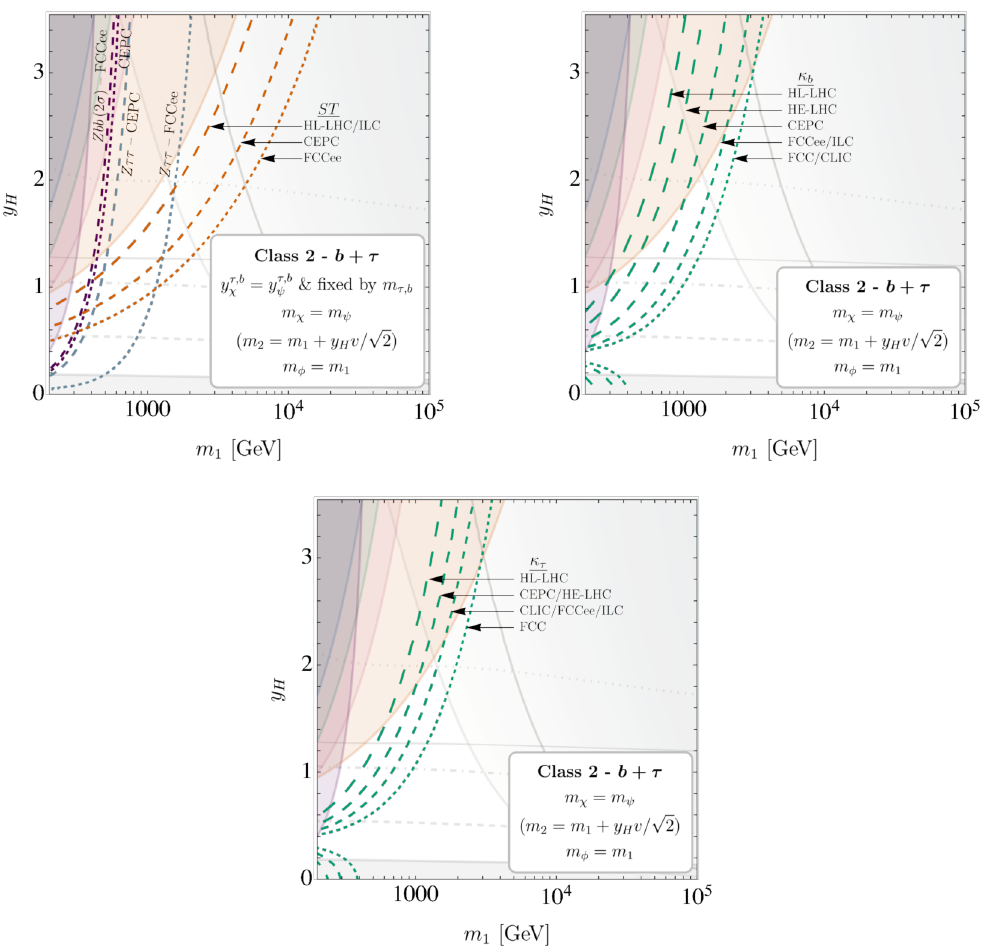
Figure 15. Projected 2 σ experimental sensitivities on the Class 2 combined b + τ benchmark model from future colliders, for the left slice of parameter space in fig. 14. In the top-left panel we have assumed y τ,b = y τ,b and fixed the values to reproduce the fermion χ ψ